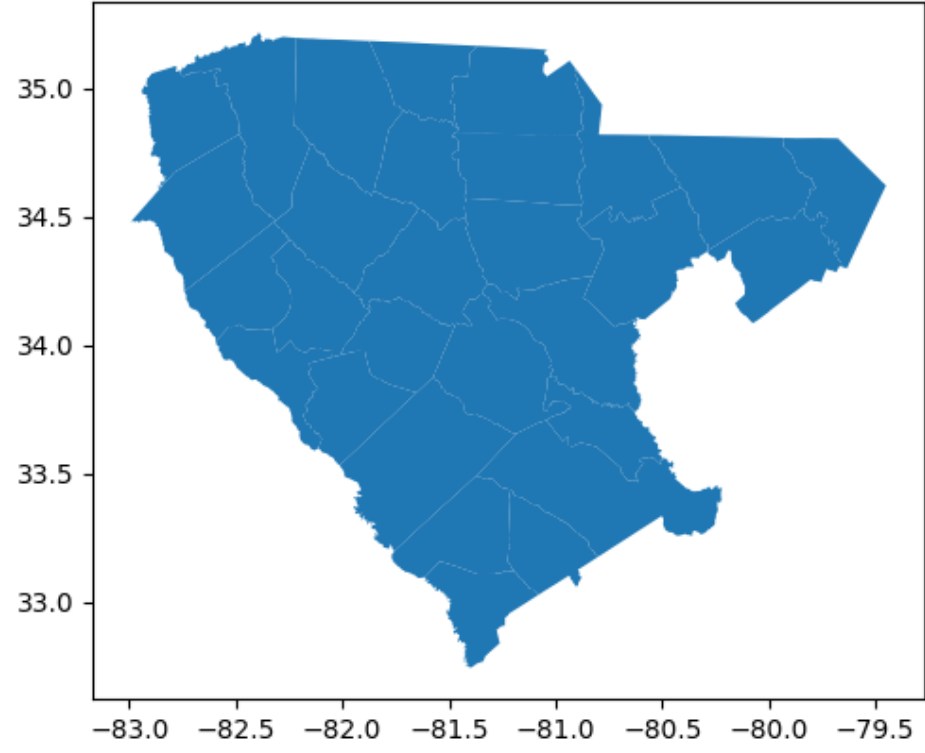
Figure 5. Geographical representation of the counties.